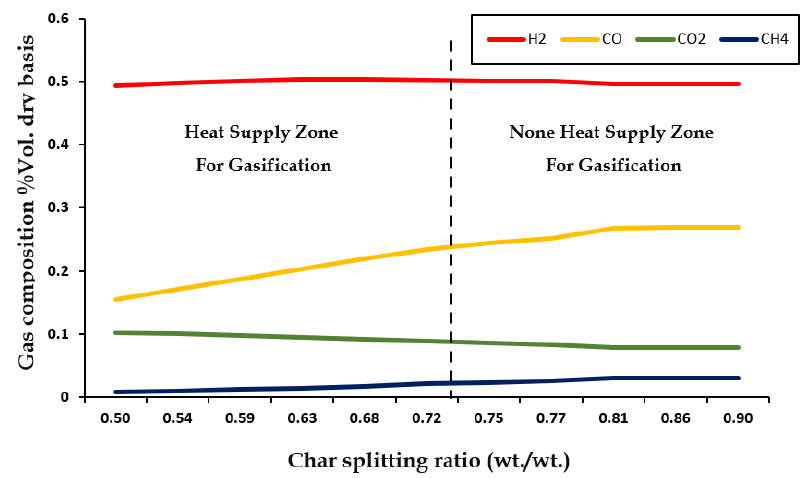
Figure 6. Effect of char splitting ratio on the gas yield.